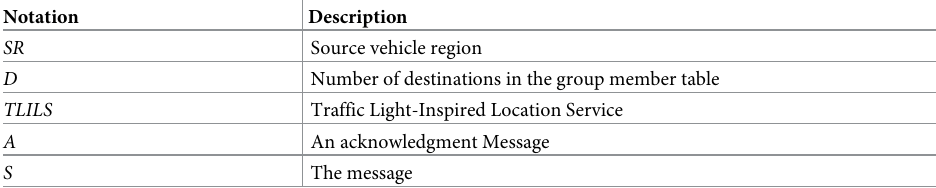
Table 4. Notations used in Algorithm 2 and its